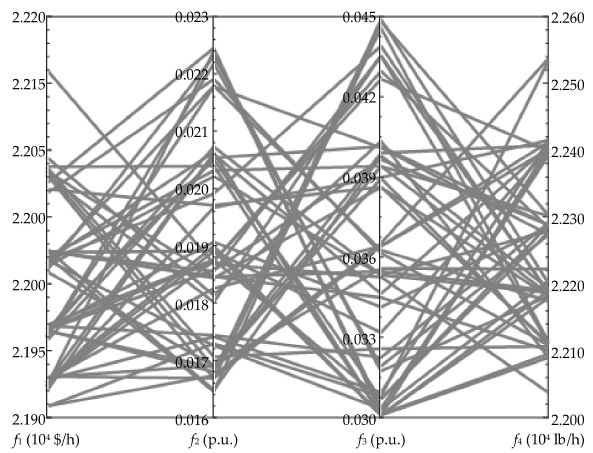
Figure 2. Distribute condition of Pareto-optimal solutions of